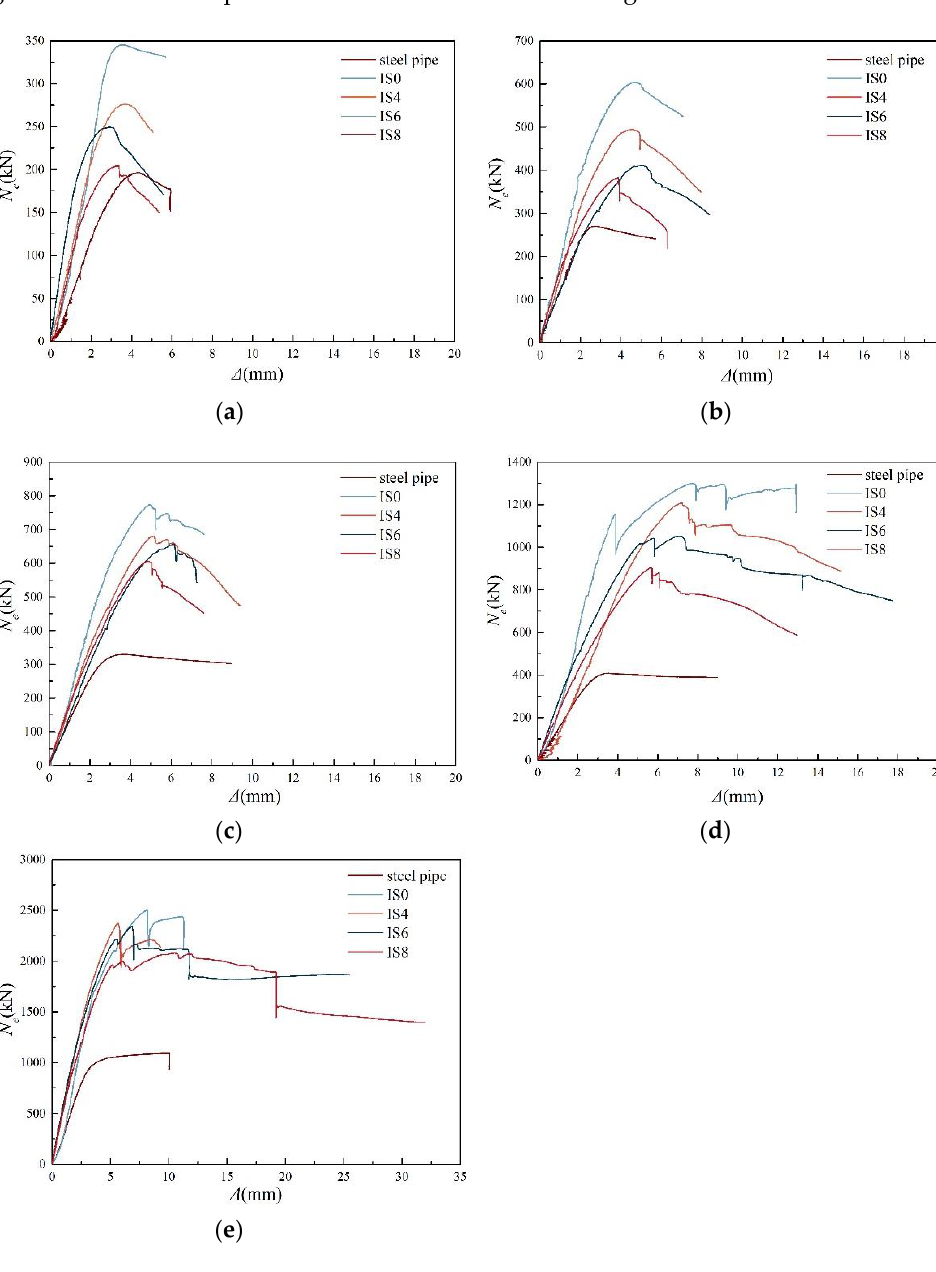
Figure 12. Load-displacement curves. ( a ) ⌀60 × 3.5 ; ( b ) ⌀75.5 × 3.75; ( c ) ⌀88.5 × 4; ( d ) ⌀114 × 4; (𝐞) ⌀159 ×